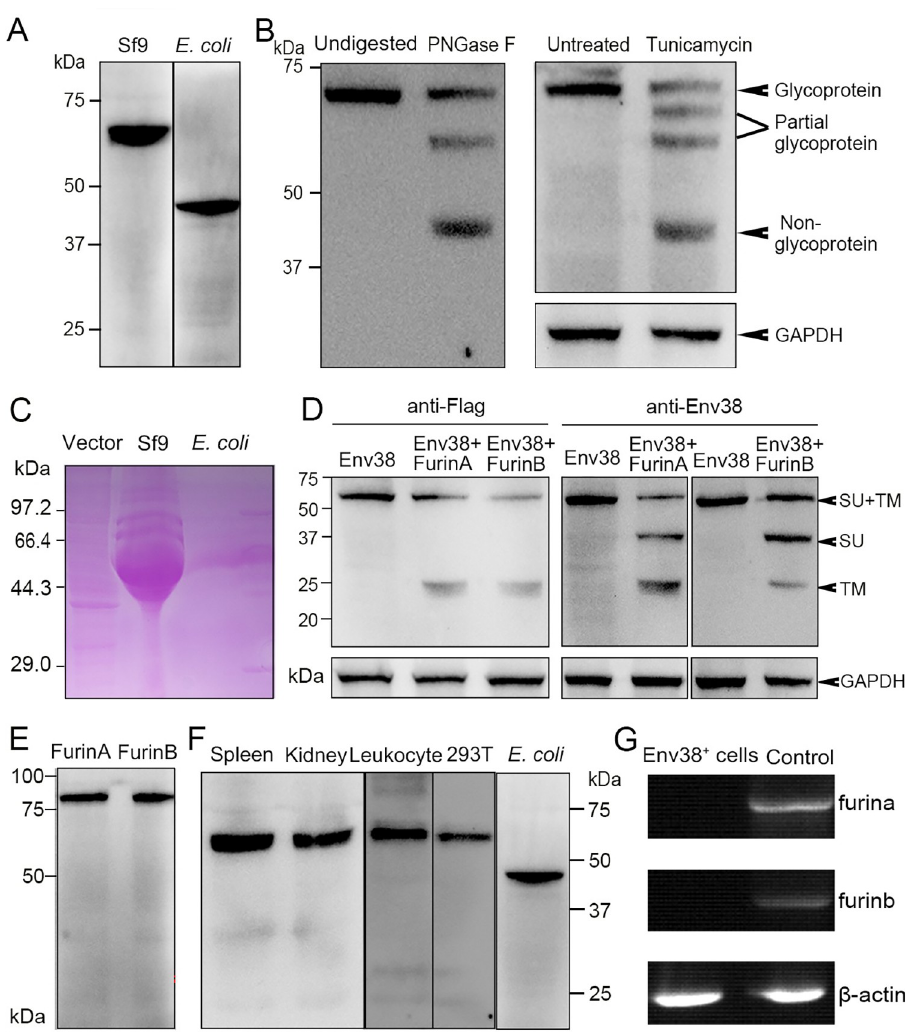
Fig 2. Examination on the expression, glycosylation and proteolysis of Env38 protein and activity of anti-Env38 Ab. (A) Western blot analysis for the expression of Env38 protein with mouse anti-His Ab (1:5,000). The Env38 proteins expressed in eukaryotic Sf9 cells and prokaryotic E . coli cells were determined to be approximately 60 kDa and 48 kDa, respectively. (B) Western blot analysis for N-glycosylation of Env38 protein with treatment of PNGase F and tunicamycin, in which the Env38 protein derived from Sf9 cells was treated with PNGase F (500 U/ml), and the Env38-expressing HEK293T cells transfected with pcDNA3.1-Flag-Env38-LTR (0.6 μ g/ml) was treated with tunicamycin (5 μ g/ml). The Env38 protein was separated by 12% SDS-PAGE. Env38 protein derived from Sf9 cells without digestion and HEK293T cells without treatment were served as controls. GAPDH was used as a loading control. (C) Detection of the glycosylation of Env38 protein by PAS reaction. The Env38 proteins were expressed in Sf9 cells or E . coli cells, and separated by 12% SDS-PAGE followed by staining with Schiff reagent. Env38 protein derived from Sf9 cells exhibited a strong positive staining, while Env38 protein derived from E . coli cells showed no staining. (D) Western blot analysis for the detection of enzymatic cleavage of Env38 protein by Furins. Coexpression of Env38 protein (with a Flag-tag at C-terminus) and FurinA or FurinB in HEK293T cells resulted in cleavage of Env38 with two protein bands corresponding to the intact Env38 protein (60 kDa) and TM subunit (25 kDa) when detected with anti- Flag Ab, and three protein bands corresponding to the intact Env38 protein (60 kDa), SU subunit (35 kDa) and TM subunit (25 kDa) when detected with mouse anti-Env38 Ab. GAPDH was used as a loading control. (E) Western blot analysis for the expression of FurinA and FurinB proteins in HEK293T cells. (F) Western blot analysis for the reactivity and specificity of mouse anti-Env38 polyclonal Ab. The anti-Env38 Ab clearly combined with the target natural Env38 proteins derived from spleen, head kidney and leukocytes, as well as recombinant Env38 proteins from HEK293T and E . coli cells with molecular weights of 60 kDa and 48 kDa, respectively. (G) Detection of the transcriptional expression of furina and furinb genes in Env38 + cells sorted from leukocytes from spleen, head kidney and peripheral blood of zebrafish stimulated with SVCV (10 5 TCID 50 ) using RT-PCR. Total leukocytes were used as a